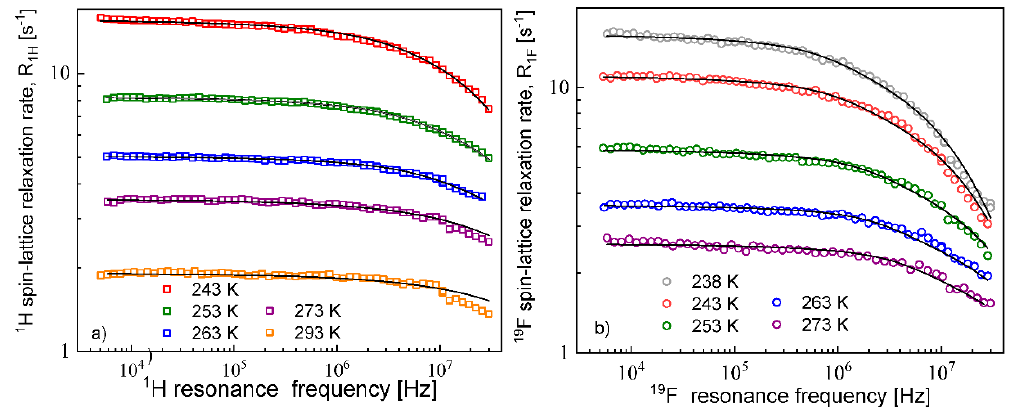
Figure 3. 1 H ( a ) and 19 F( b ) spin–lattice relaxation rates for EMIM-FSI in bulk; lines—fits in terms of Equation (7).